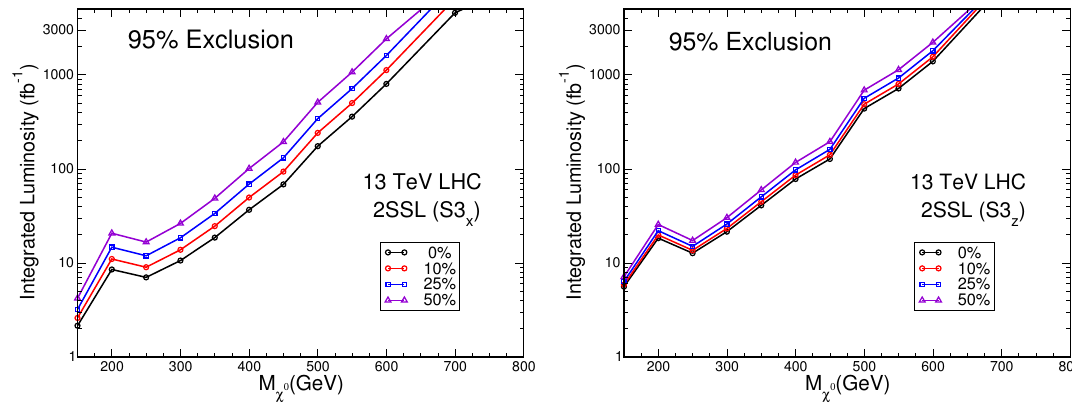
Figure 9 . In the left panel, we show the required integrated luminosity for 95% CL exclusion ( Z exc 1.645) after imposing the S 3 x selection criteria in the 2SSL channel at the 13 TeV LHC as (cid:21) a function of M . The right panel depicts the same for selection criteria S 3 z . The colored lines in (cid:31) 0 both the panels are for the di(cid:11)erent level of uncertainties in the background events ranging from 0 to 50%.